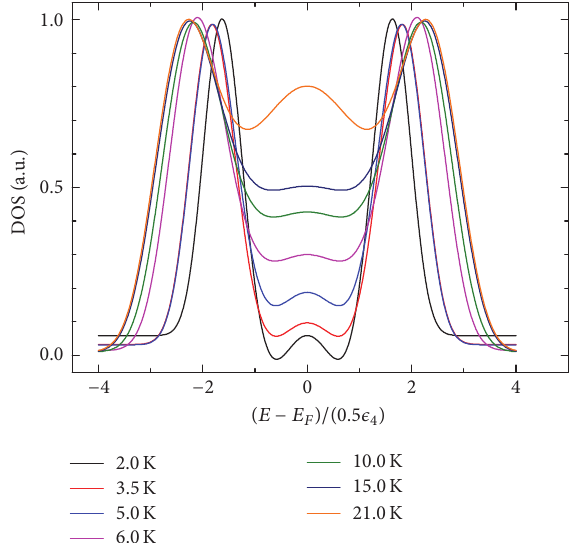
Figure 12: DOS at different temperatures as obtained from the experimental data within the proposed model (see